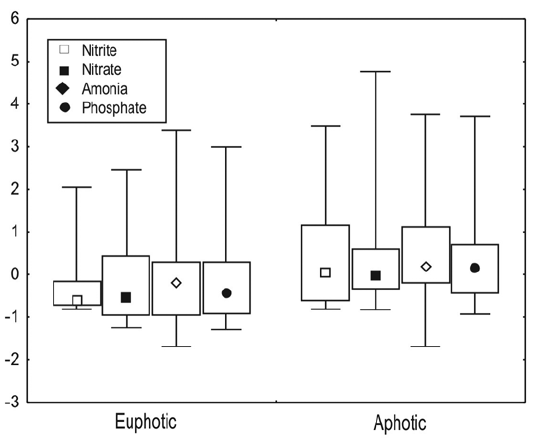
Fig. 3 – Autoscaled value distributions for temperature and salinity.